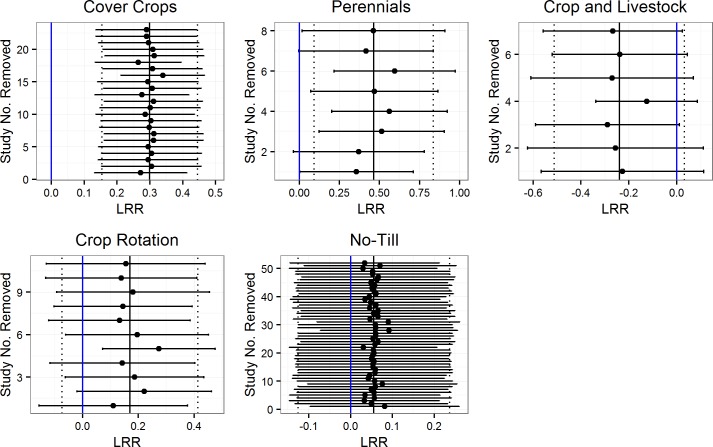
Sensitivity of results to individual studies using a Jacknife technique.Blue lines represent zero or no effect, and 95% confidence intervals that do not cross zero were considered significant. The solid black line represents the overall practice means and the dashed lines are overall 95% confidence interval before individual studies were removed to re-calculate the displayed means and confidence intervals.